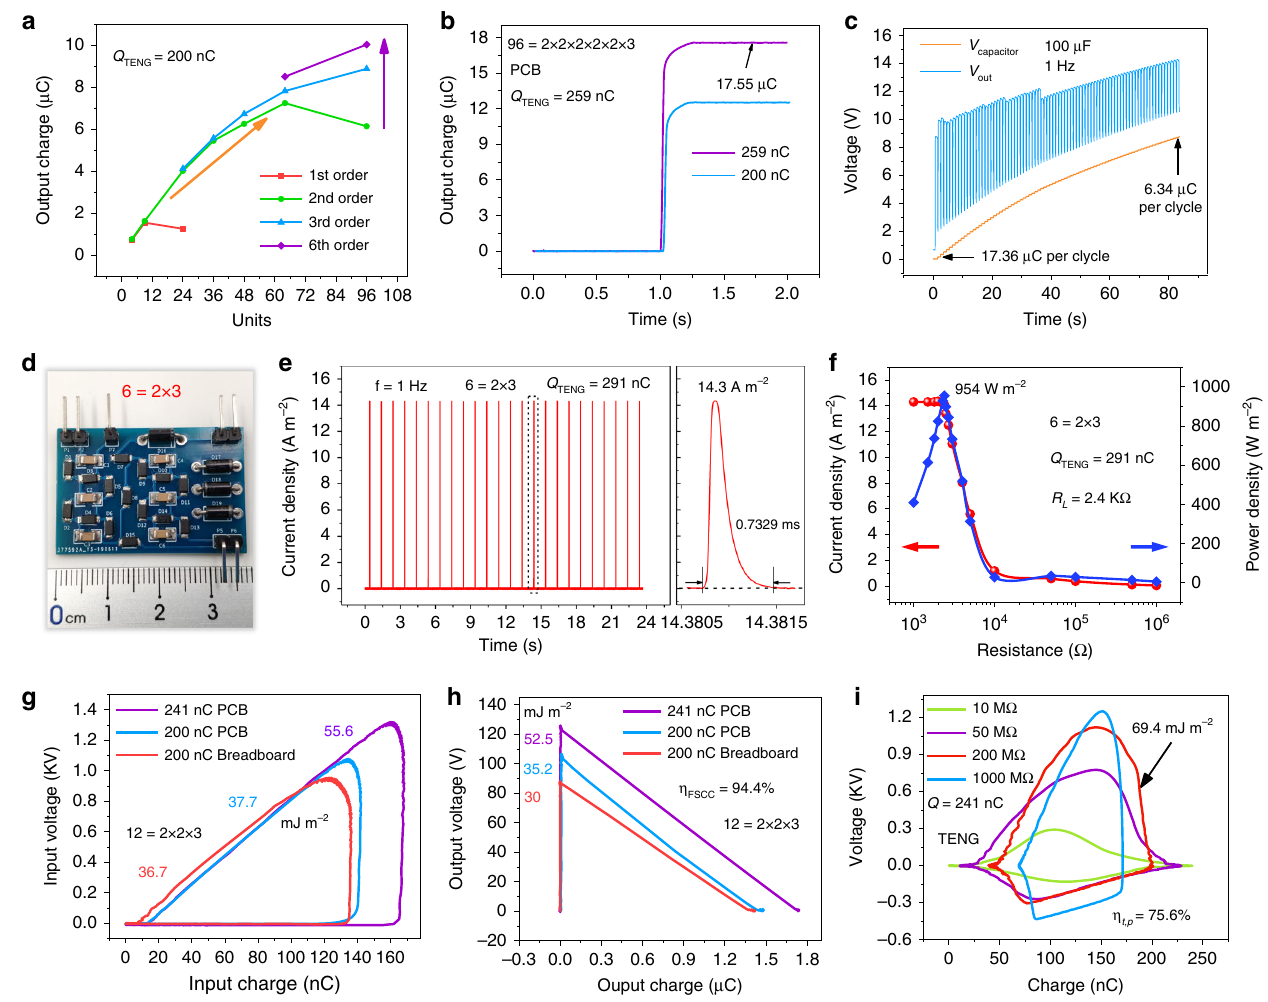
Fig. 3 Maximizing pulse output with FSCC power management system. a The output charge of FSCC with different orders and units per cycle (components are integrated on breadboard) at driving frequency of 1 Hz and TENG area of 20 cm − 2 . b The maximum output charges of 96-unit FSCC per cycle, indicating 67.8 times charge boosting. c The voltage cumulative effect of FSCC that the open-circuit output voltage can increase with the increase in load voltage. d A photograph of 6 = 2 × 3 FSCC integrated on a printing circuit board (PCB). e The output current density of 6-unit FSCC, achieving a super- high current density of 14.3 A m − 2 per cycle. f The maximum power output of FSCC power management system per cycle, obtaining 192 times power boosting. g Energy input into FSCC per cycle from TENG under different charge quantities. h The maximum output energy of FSCC per cycle under different charge quantities in TENG. i Energy consumption per cycle on different resistances provided by TENG